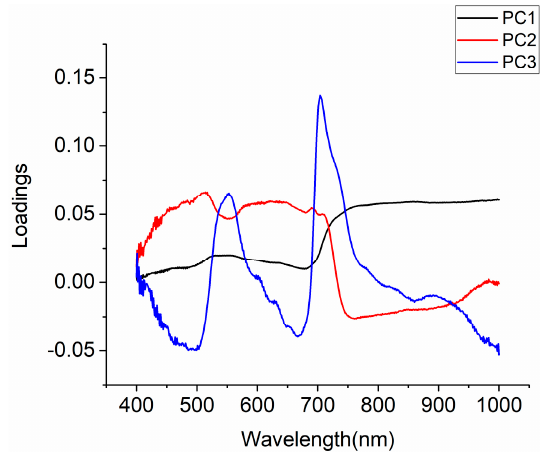
Figure 2. Loading weights of the first three principal components (PCs) of the ASD reflectance spectra.